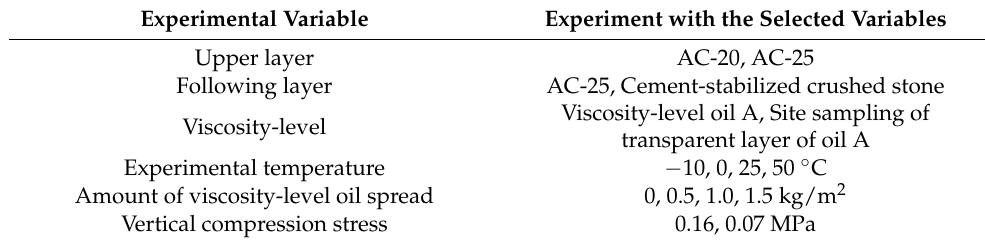
Table 10. Experimental parameters to verify the effect of vertical load. Experimental